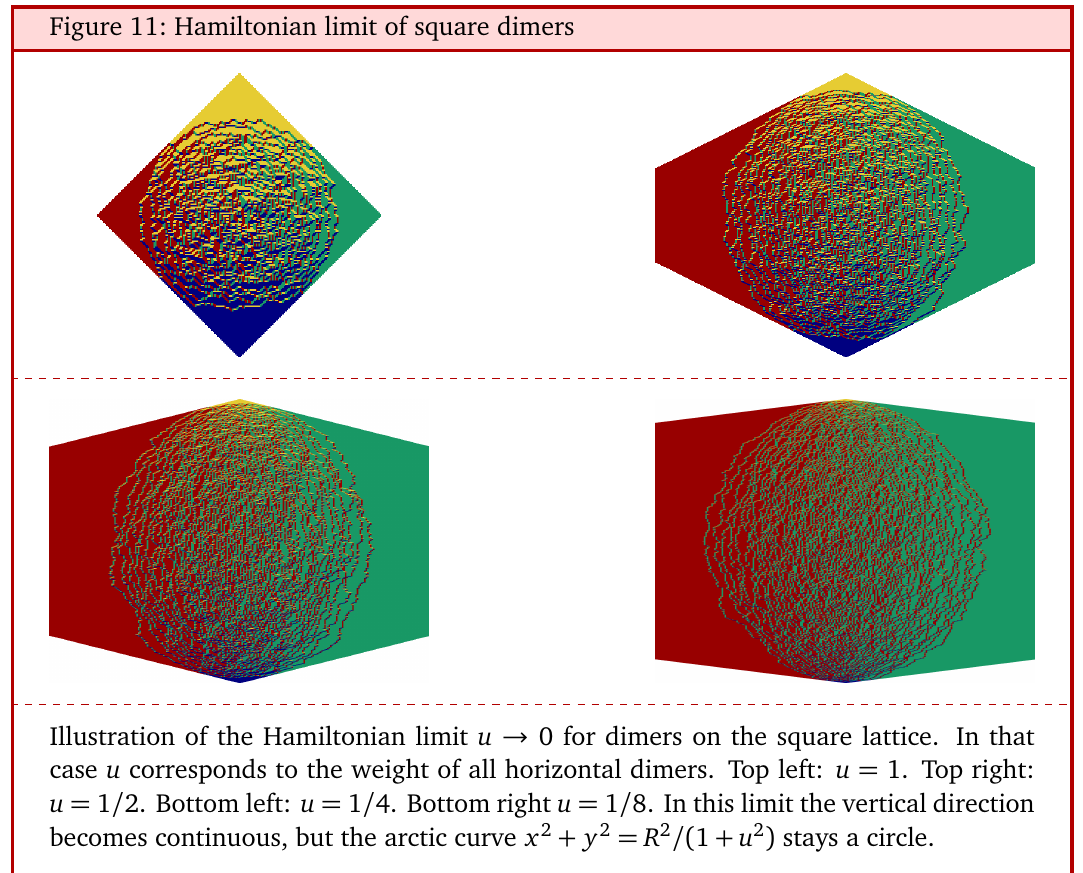
Figure 11: Hamiltonian limit of square dimers